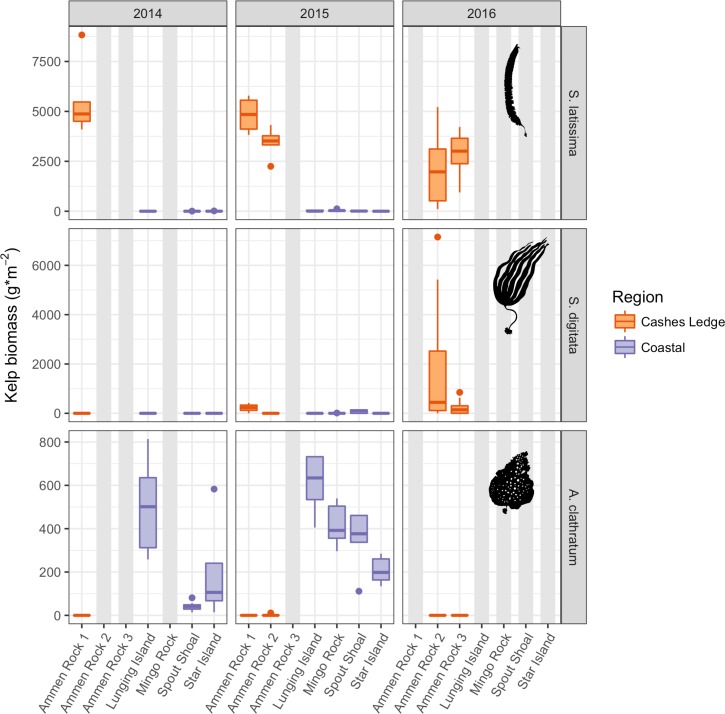
Kelp biomass.Boxplots display the median value of the data as a horizontal bar, the first and third quartiles of the data (25th and 75th percentiles) as a shaded box around the mean, 1.5x the interquartile range (IQR) as a vertical line, and all outliers beyond +/- 1.5 IQR as individual dots. Ammen Rock sites on Cashes Ledge are colored orange while data from coastal sites are purple. These graphical representations are repeated in all subsequent plots. Note that the y-axis ranges are different for each species. Grey shaded areas indicate sites that were not sampled in that year.